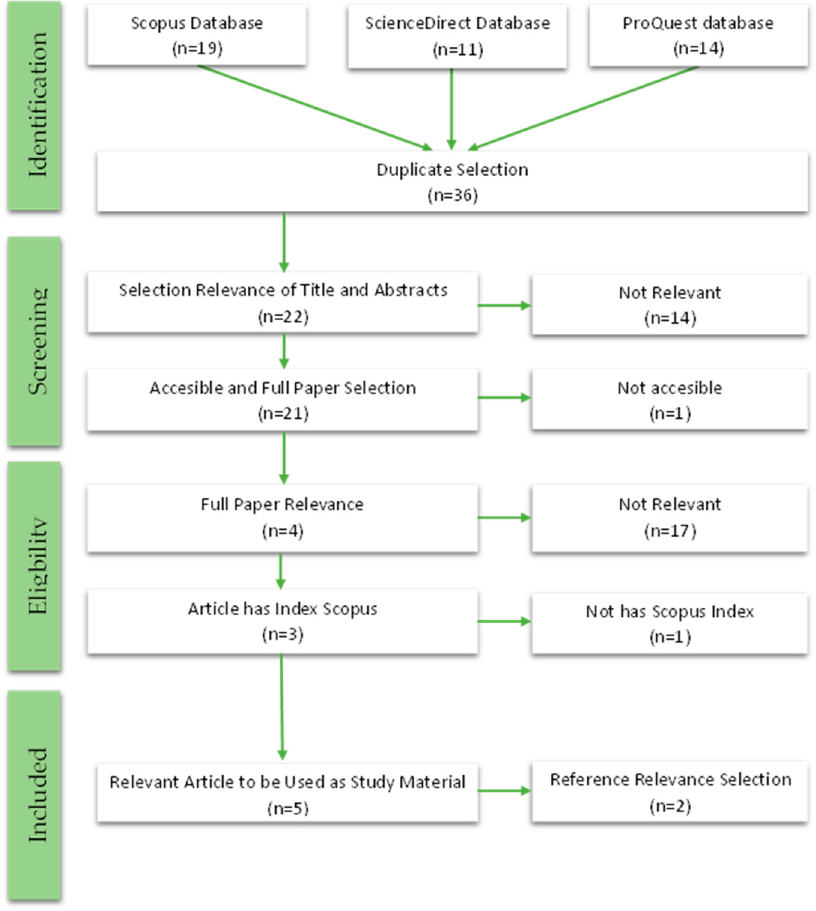
Figure 1. PRISMA diagram based on the keywords used.